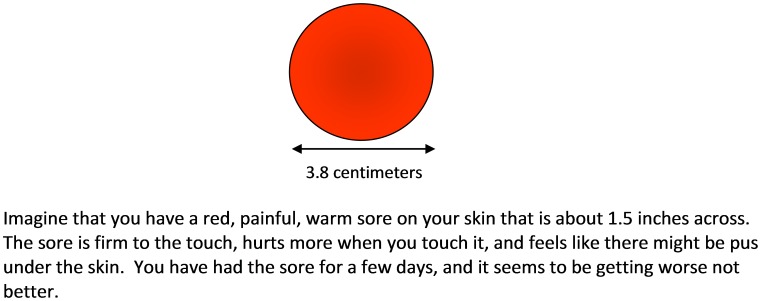
Description of Non-Draining Sore Vignette.